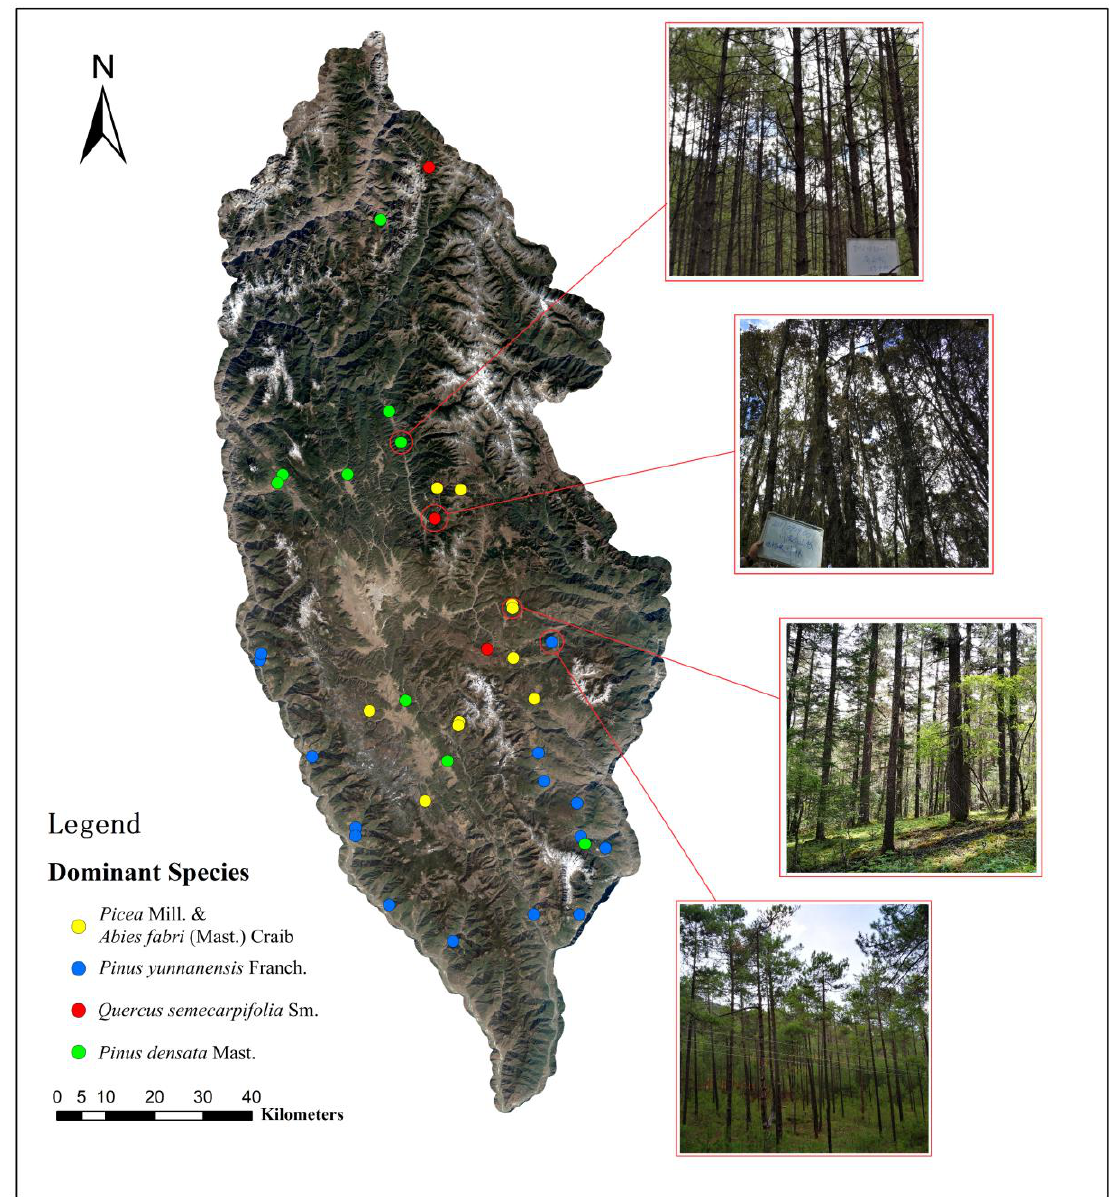
Figure 2. Forest sample plots in Shangri-La, Yunnan, China.